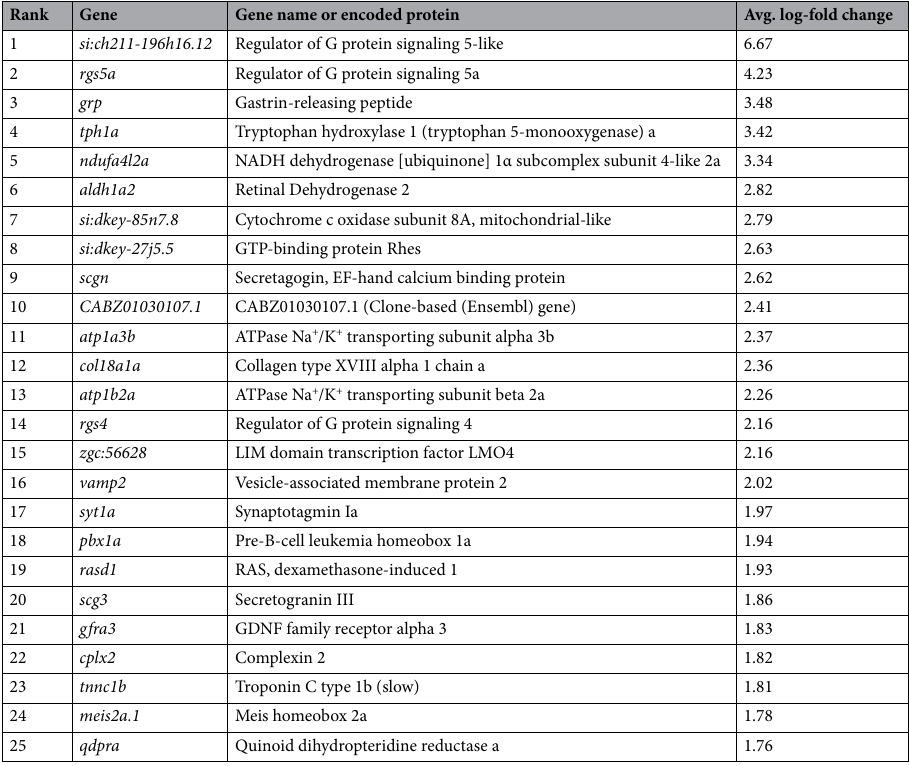
Table 1. The top 25 most abundant genes in the neuroepithelial cell (NEC) cluster. Average log-fold change indicates higher expression over other cell types. The adjusted P-value for each gene was < 0.05. See Supplementary Table S1 for the full list of genes within each cell